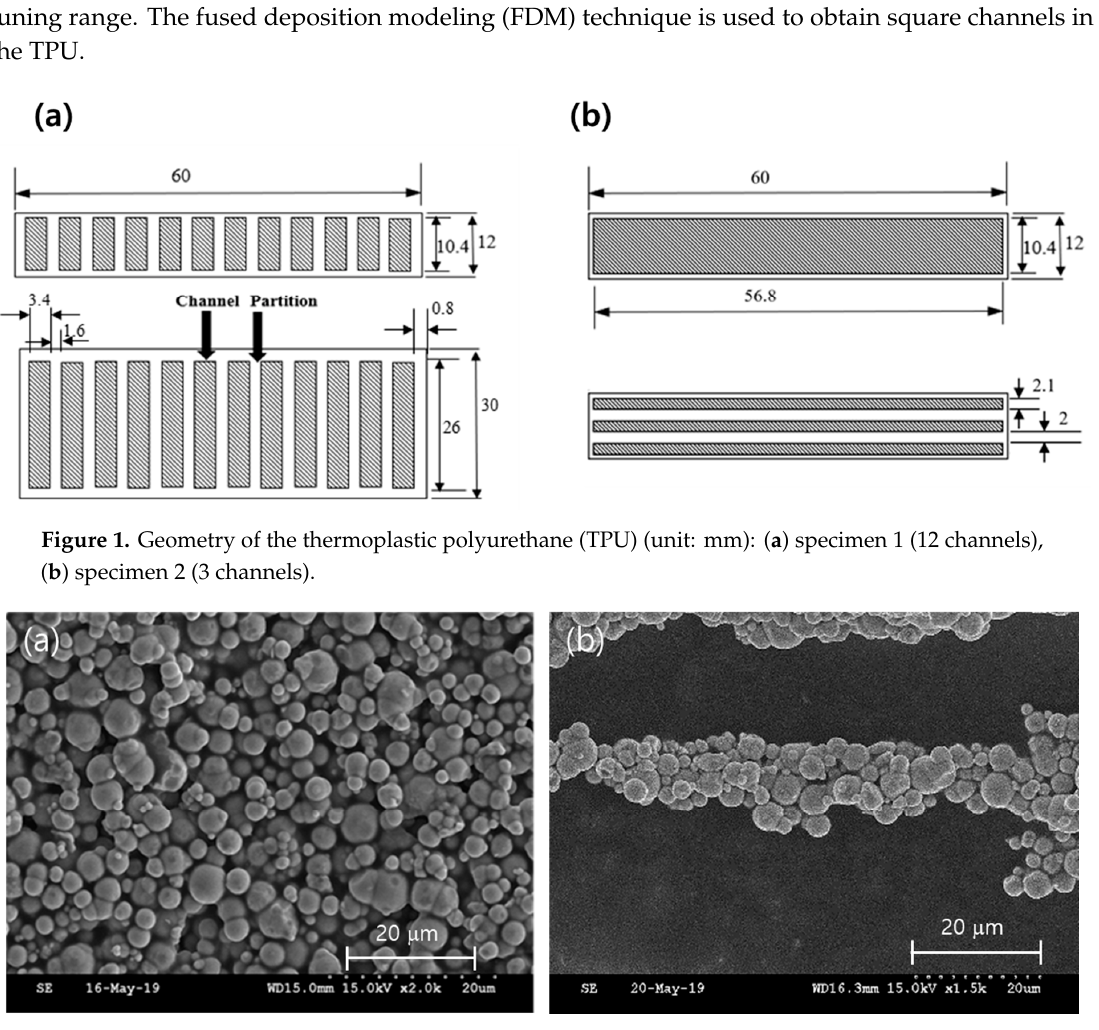
Figure 2. SEM images of the magnetorheological fluid (MRF) ( a ) without the magnetic field and ( b ) under the magnetic field.